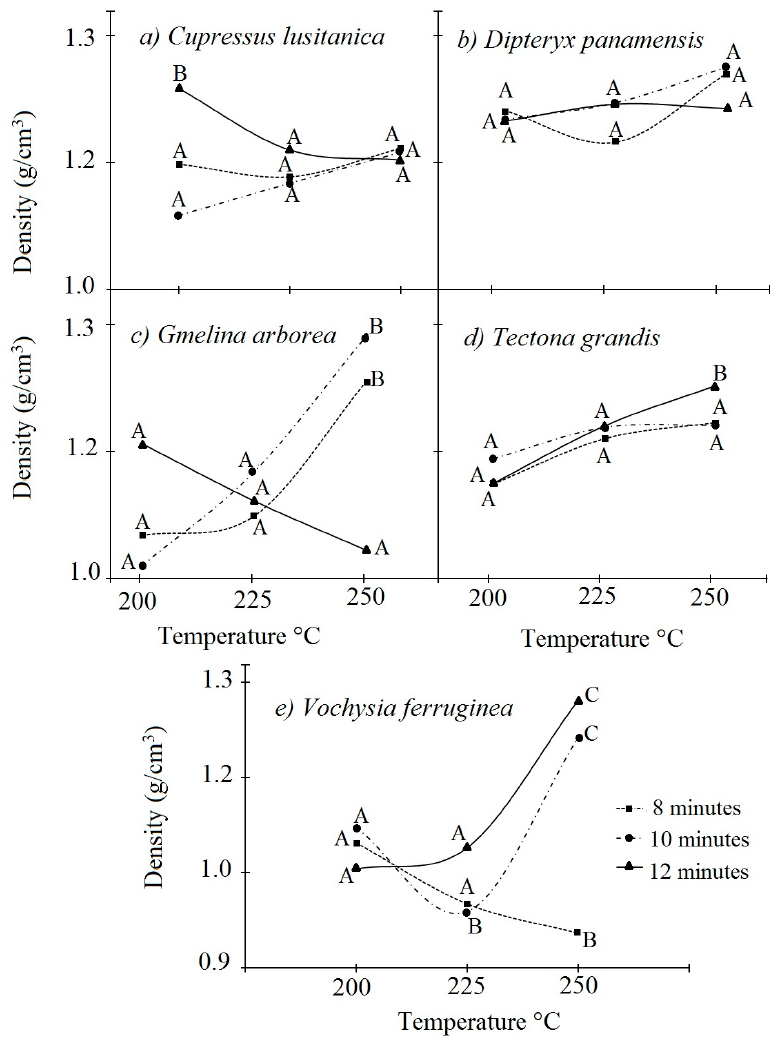
Figure 2. Density of pellets torrefied at different temperatures and times of five types of biomass from woody tropical species: ( a ) Cupressus lusitanica ; ( b ) Dipteryx panamensis ; ( c ) Gmelina arborea ; ( d ) Tectona grandis ; ( e ) Vochysia ferruginea.